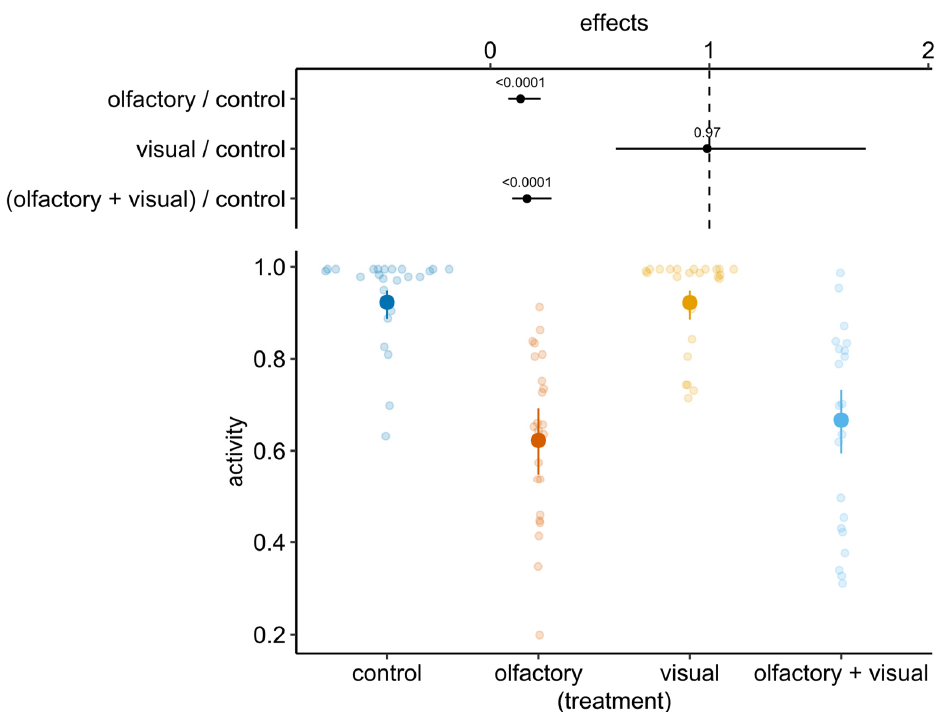
Figure 3. Estimated means of tadpole post-stimulus activity (larger coloured points) and relative 95% CI (vertical bars) from the beta mixed model. The top of the plot shows the estimated effects (ratio) as comparison with control treatment (absence of both predator visual and olfactory cues); estimates not overlapping with the vertical dashed line (i.e., ratio = 1) indicate significant difference in comparison with control treatment.